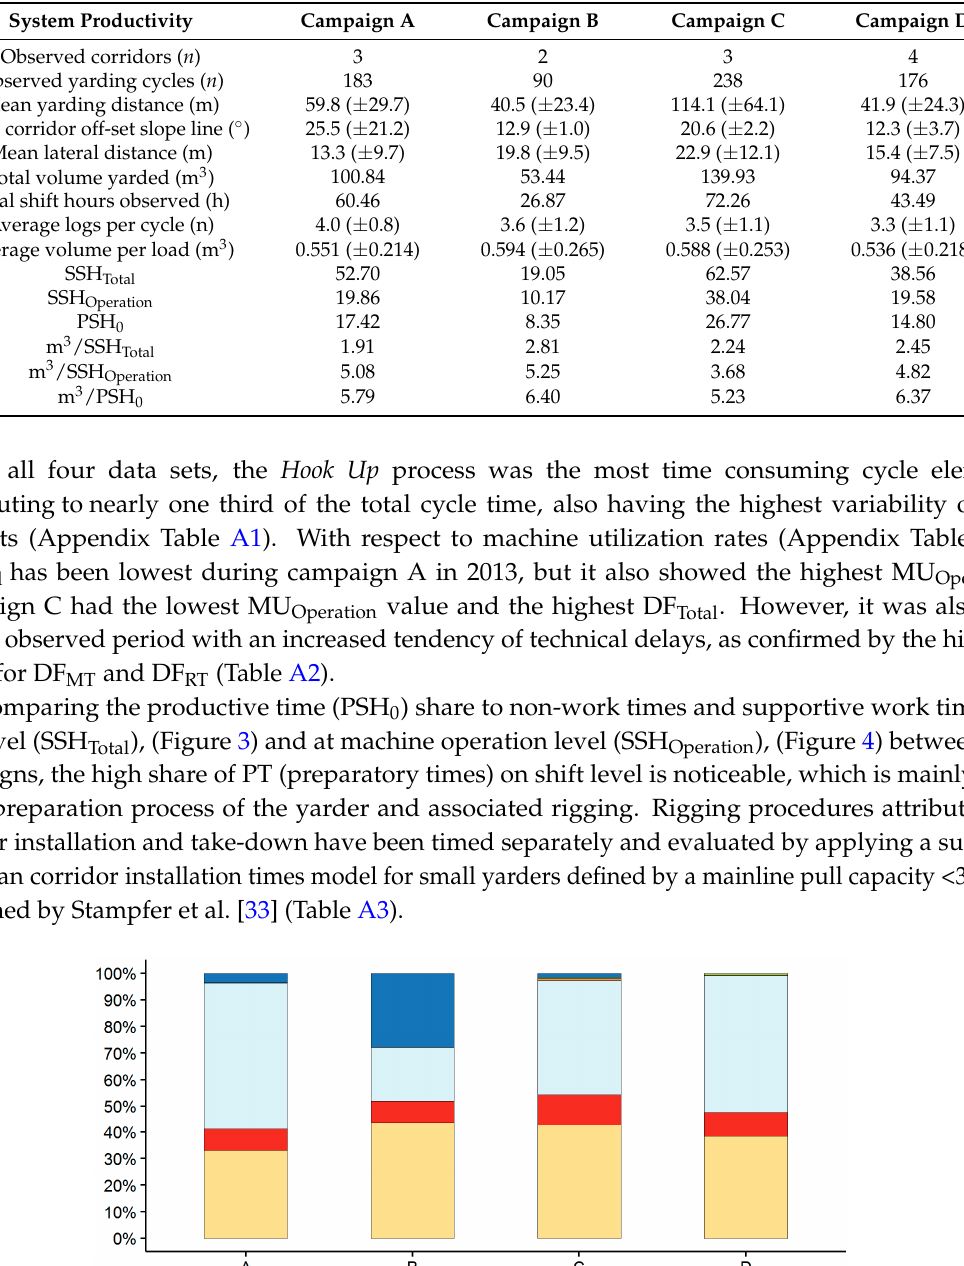
Table 4. System Productivity Parameters as Measured During the Four Field Campaigns. Standard Deviations in Parenthesis.